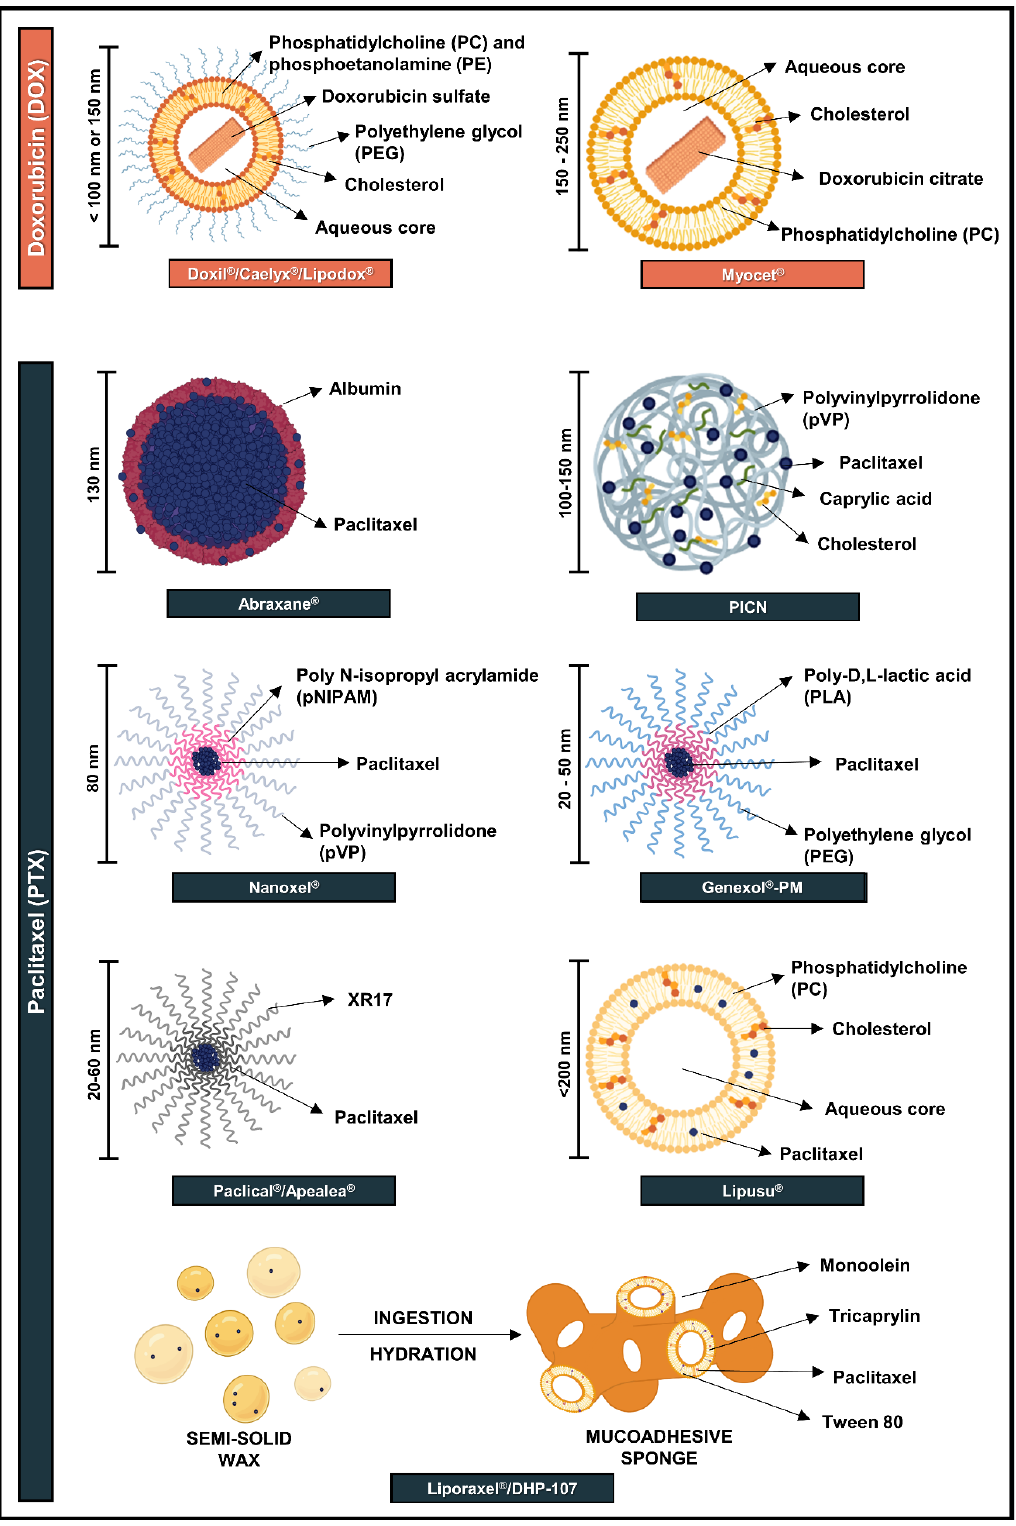
Figure 3. Approved nanoformulations employing doxorubicin (DOX) or paclitaxel (PTX) and their respective compositions. For DOX, there are two types of liposomes: pegylated and non-pegylated, whereas PTX presents a wider variety of nanocarriers: polymeric nanoparticles, polymeric micelles, and lipid-based formulations. (XR17 = isoforms of N-retinoyl-cysteic acid methyl esters) (Created with